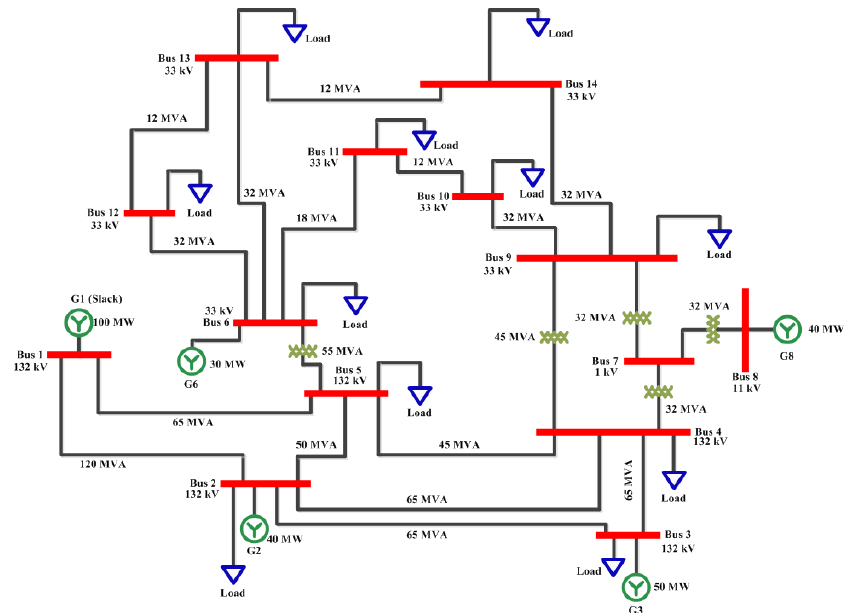
Figure 1. Modified single-line diagram of IEEE 14-bus system.